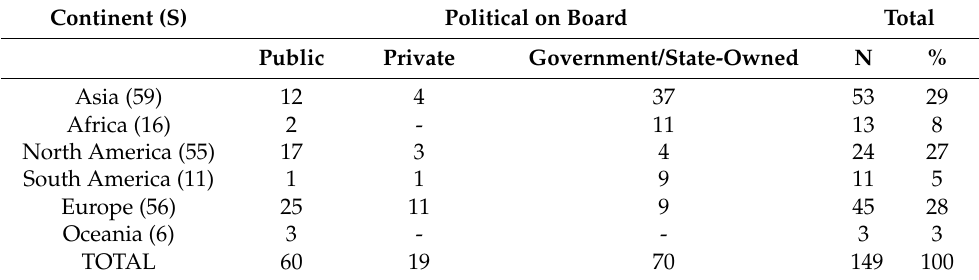
Table 2. Political on board.